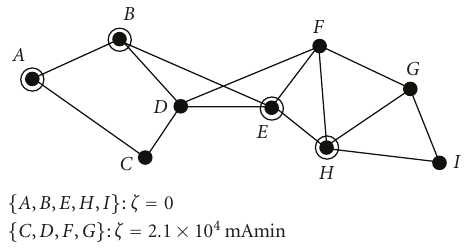
Figure 5: The battery-aware connected dominating set (BACDS) for the network in Figure 1 at t = 10minutes. The ζ i ( t ) for each node i is listed above.